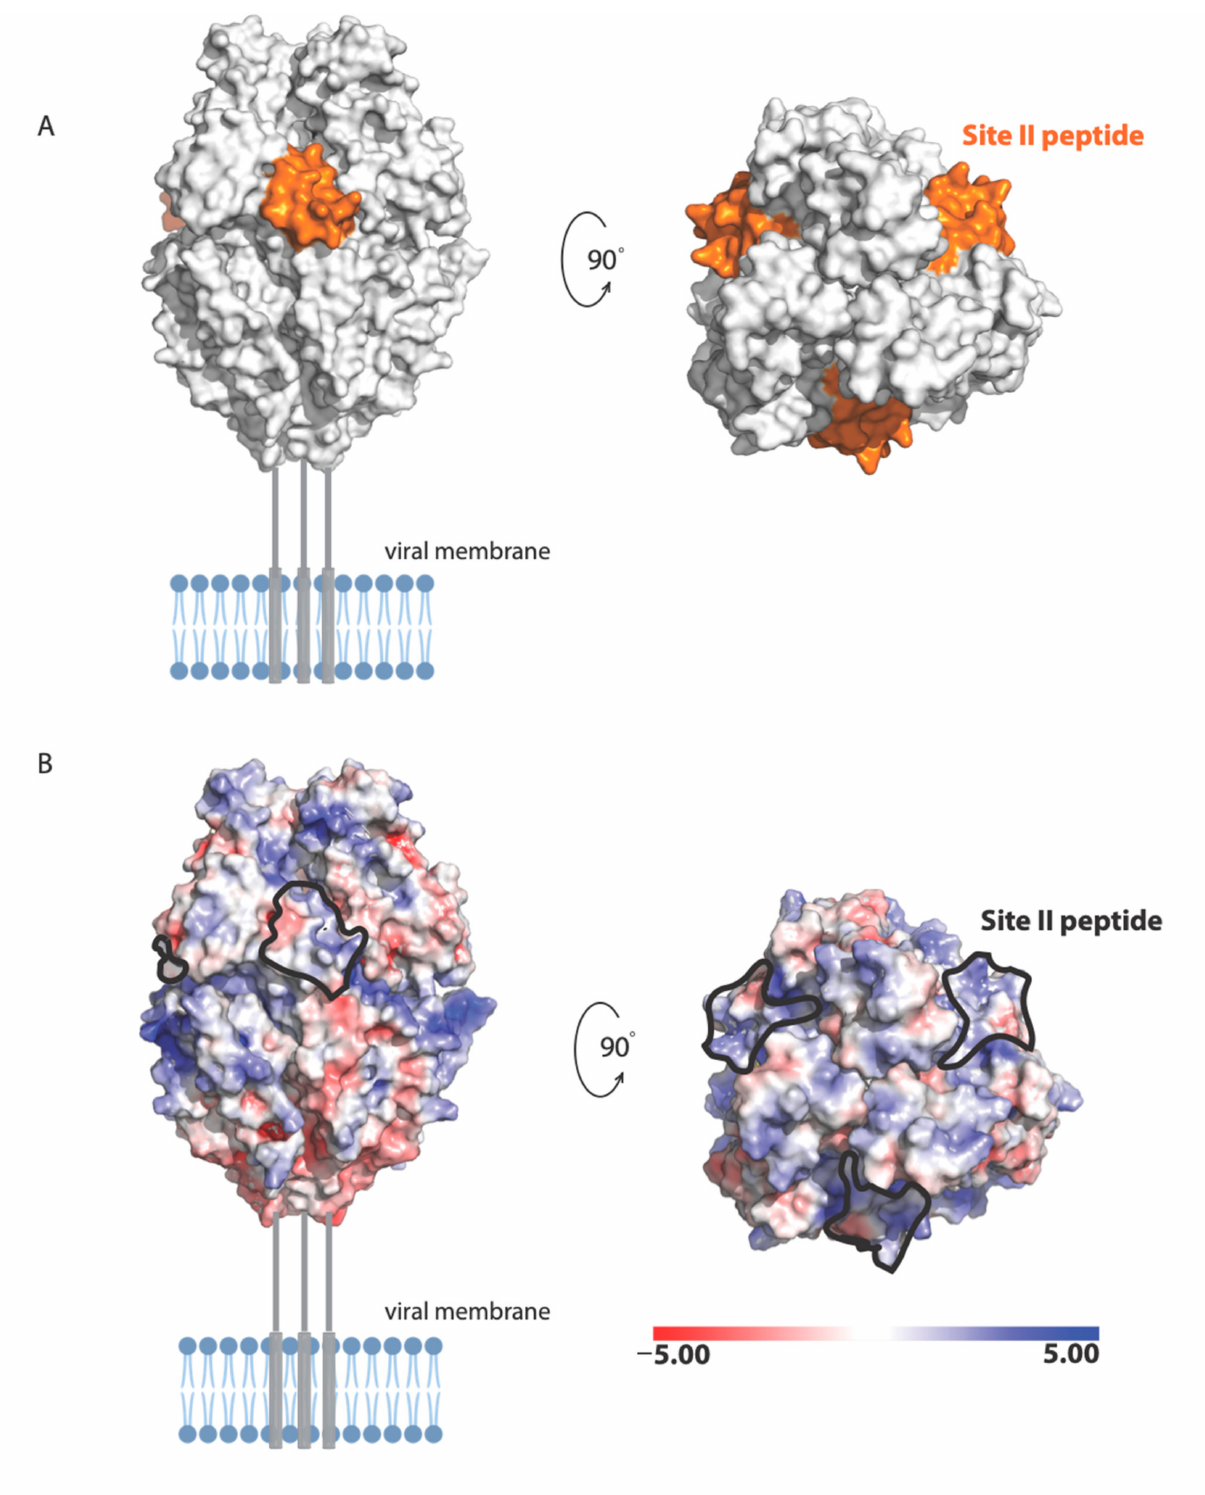
Figure 8. Illustration of the RSV-F trimer in the prefusion state (PDB code: 6VKD): ( A ) The site II peptide, highlighted in orange, may be important in RBD1,2 binding; ( B ) The electrostatic potential mapped onto the surface of RSV-F, with the location of site II epitope indicated with dotted lines. Electrostatic potential units are in KT/e. Missing regions are shown as grey